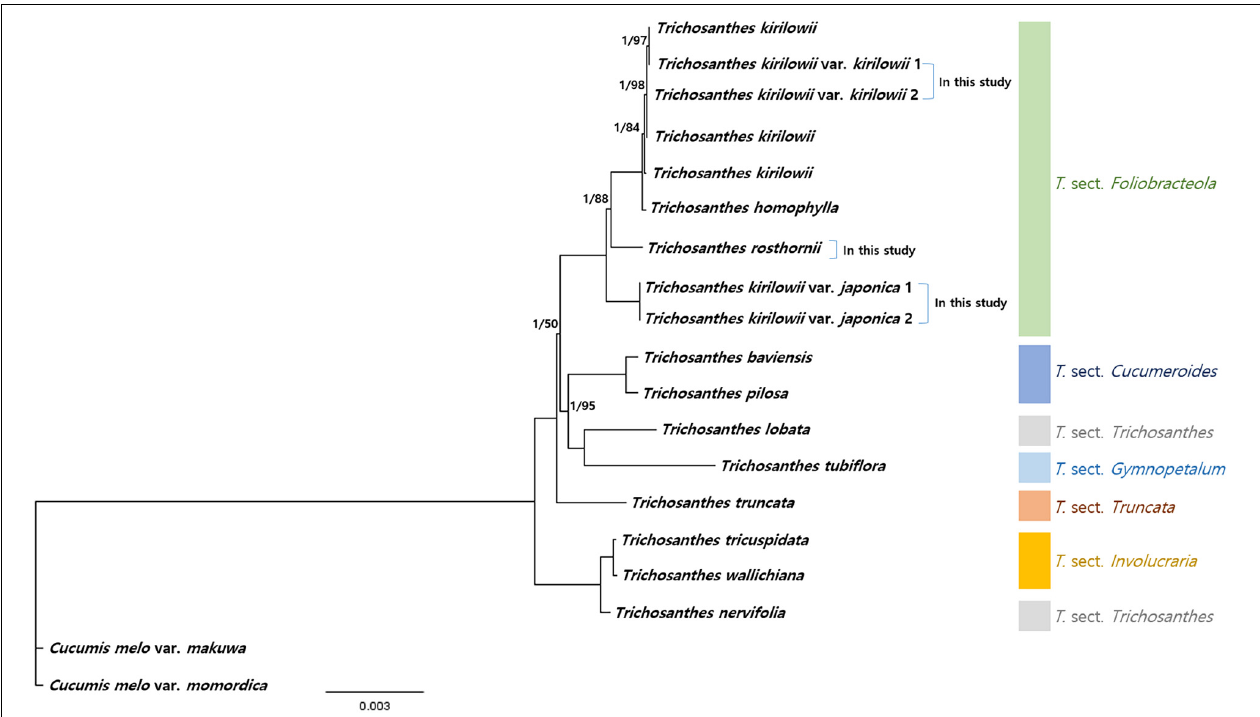
FIGURE 7 | Phylogenetic relationships of Trichosanthes . Bayesian Inference (BI) topology is shown. The numbers above branches represent BI posterior probability, and Maximum Likelihood (ML) bootstrap support; branches without support values have maximum support (PP 1, BS